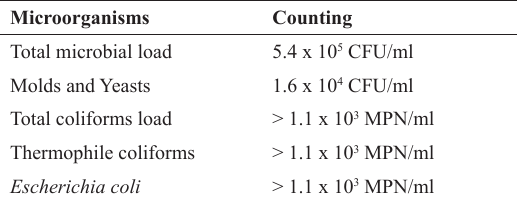
Table 4: Total Viable Count (TVC) and Most Probable Number (MPN) results.